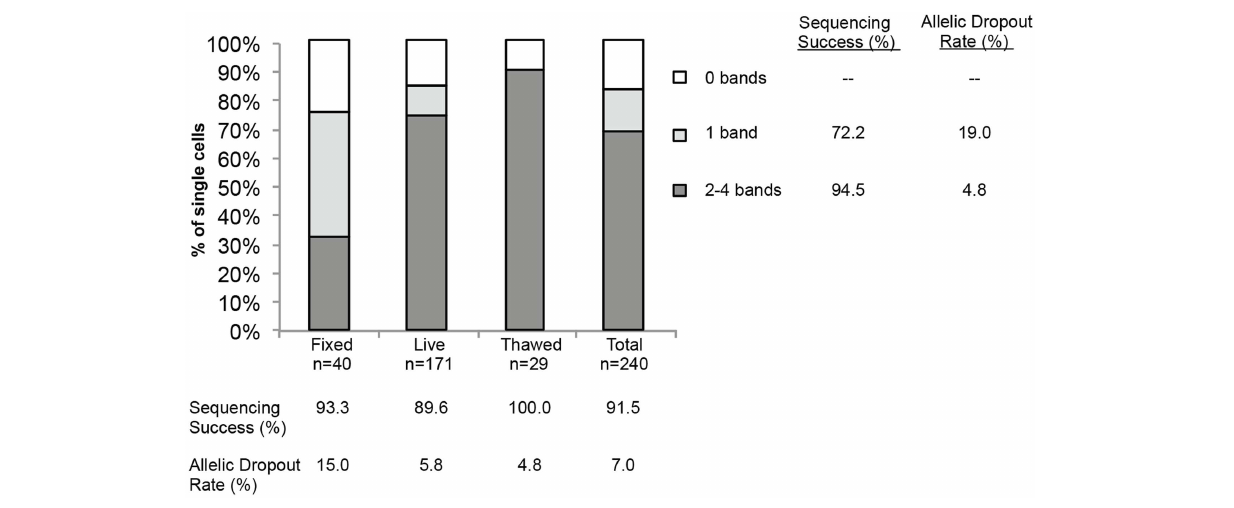
FIGURE 4 | Sequencing success and allelic dropout (ADO) rate .Two hundred forty single cells, including tumor cells ( n = 208) andWBCs ( n = 32), were collected from spiking experiments and subjected toWGA. Among the 240 single cells, 40 fixed, 171 live, and 29 thawed cells were analyzed for the number of bands detected on the post-WGA Q/C gel.The